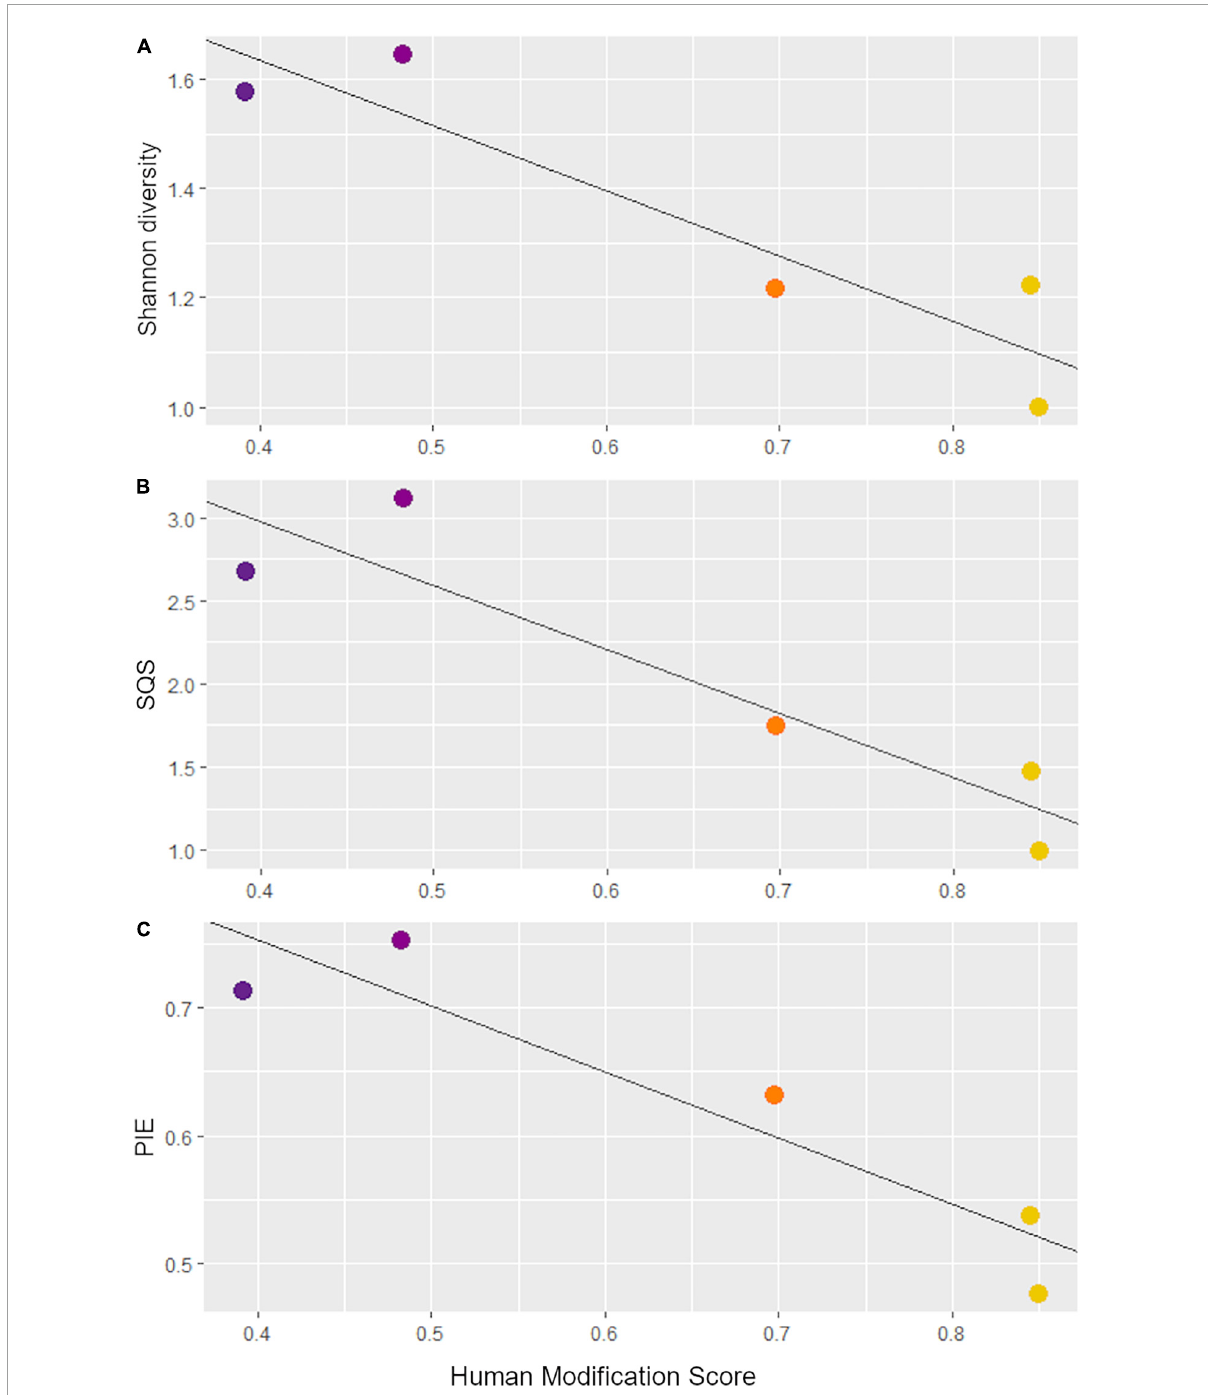
FIGURE2 Linear regressions of the human modification scores for each Anthropocene collection site versus (A) Shannon diversity, (B) shareholder quorum subsampling (with a quorum of 0.7 and 1,000 iterations), and (C) probability of interspecific encounter values. Points are colored based on their human modification score according to the scale in Figure 1